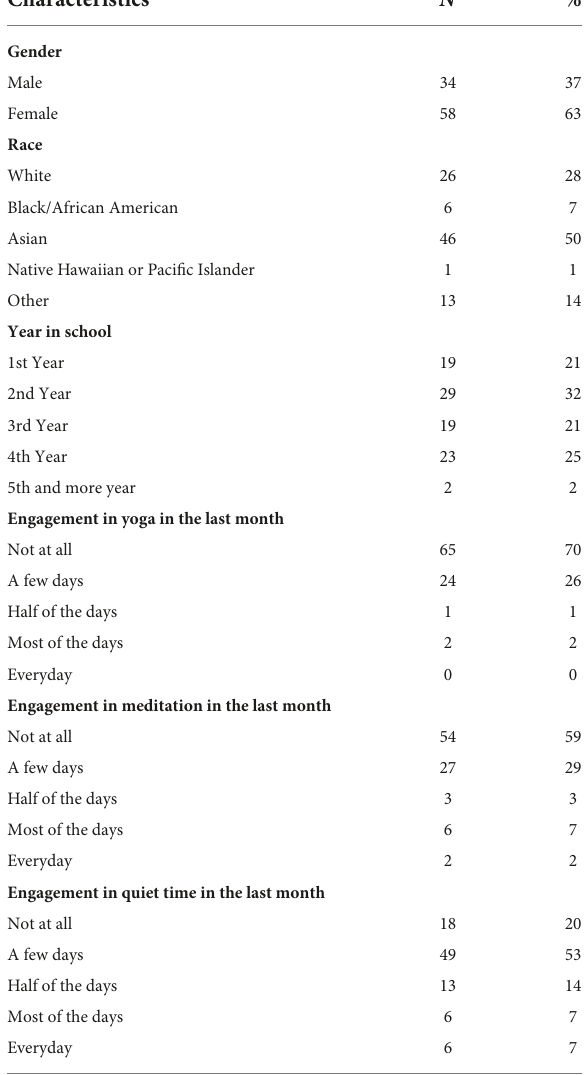
TABLE 2 Sociodemographic characteristics of participants at baseline ( N =